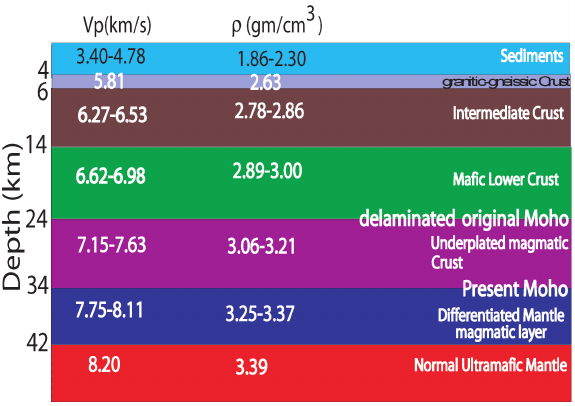
Fig. 3. Crustal seismic section beneath the epicentral zone of the 2001 Bhuj earthquake [23.3 ◦ –23.7 ◦ N; 69.9 ◦ –70.2 ◦ E] (Mandal and Pandey,